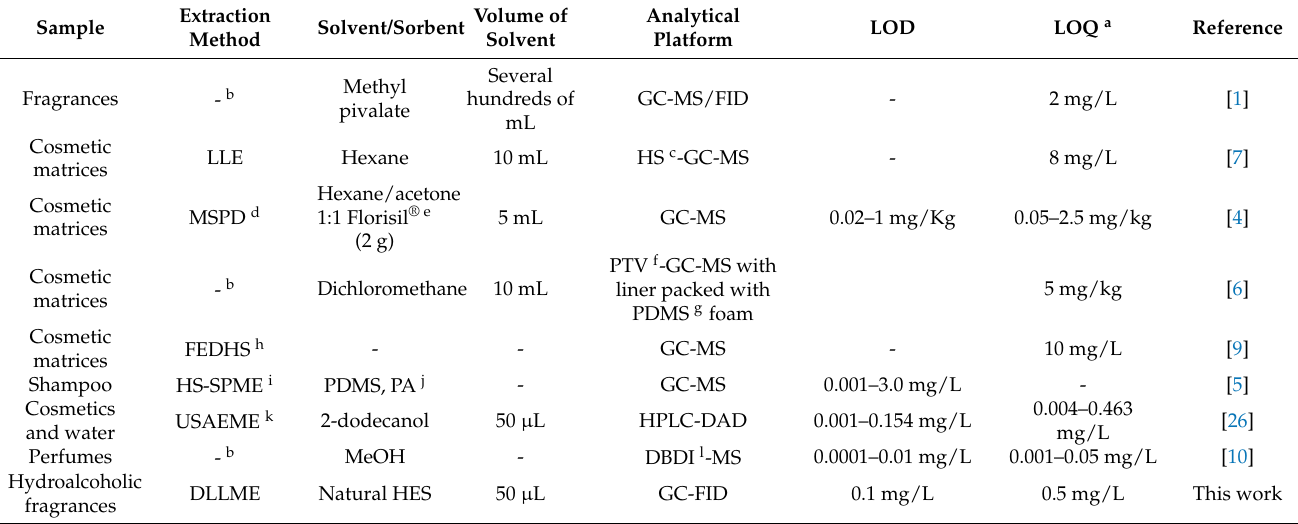
Table 4. Comparison of the proposed HES-based DLLME and other representative methods devel- oped for the determination of suspected allergens in fragrances.